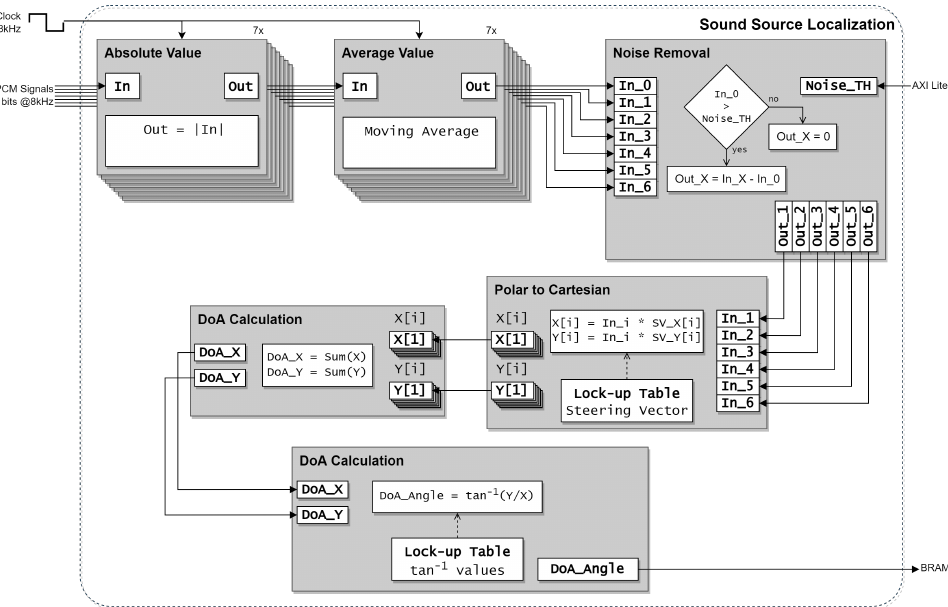
Figure 6. Block diagram of the energy sound source localization